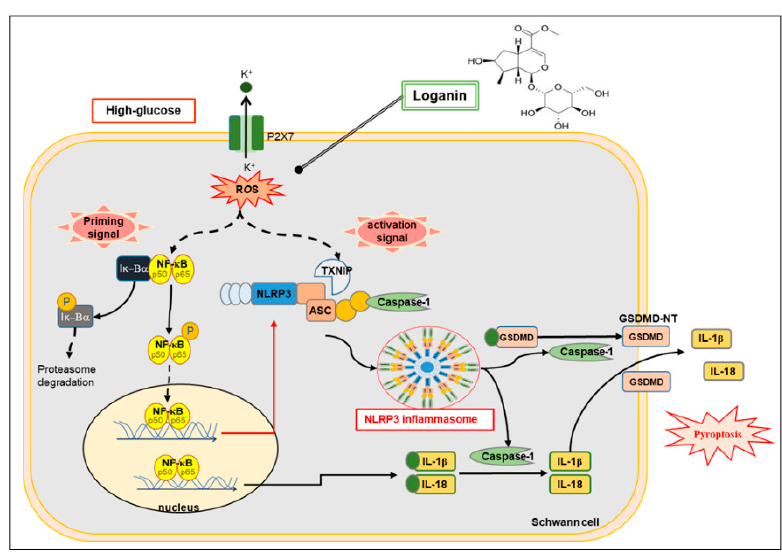
Figure 7. Schematic diagram summarizing the proposed mechanism by which loganin attenuates Schematic diagram summarizing the proposed mechanism by which pyroptotic death in high-glucose-induced rat RSC96 Schwann cells by inhibiting ROS generation and NLRP3 inflammasome activation. ROS—reactive oxygen species; NLRP3—NOD-like receptor